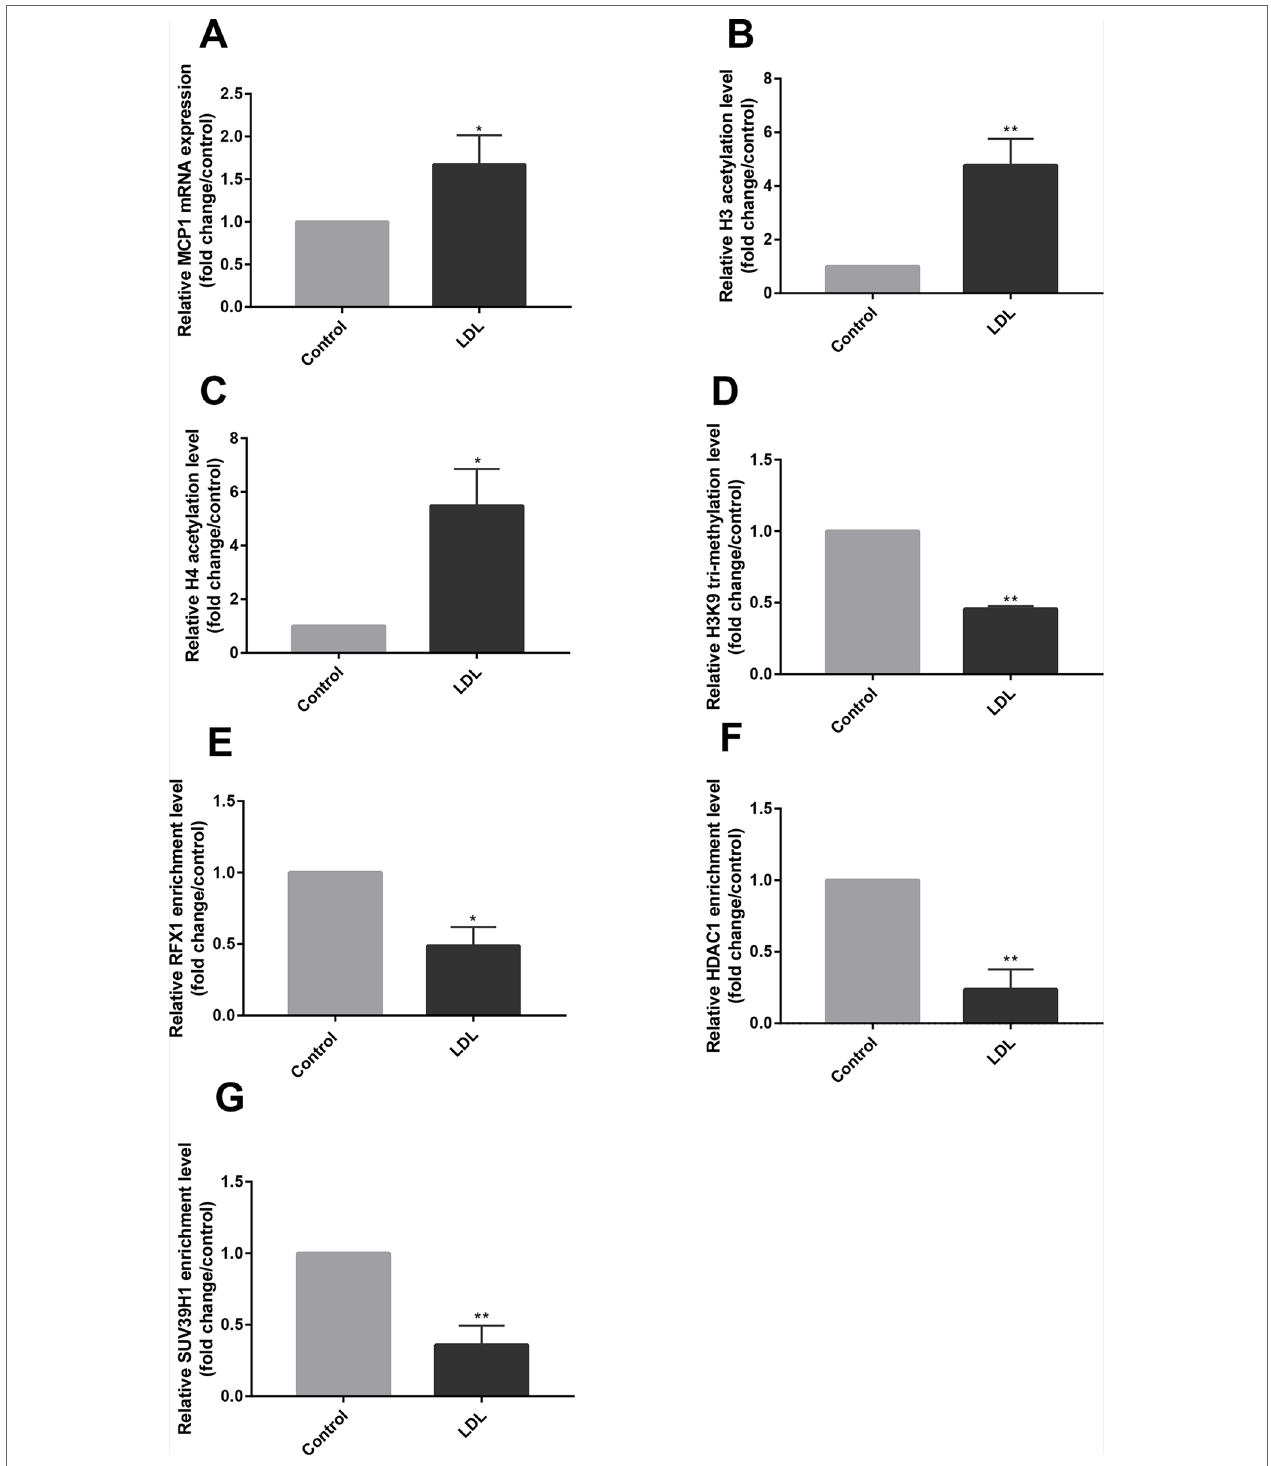
FigURE 3 | LDL altered histone modifications of the MCP1 promoter region in CD14+ monocytes. CD14+ monocytes were treated with LDL at 100 mg/L for 24 h. (a) The relative mRNA expression of MCP1 in CD14+ monocytes was detected by RT-qPCR. (B – D) ChIP-qPCR was used to measure the fold change of relative histone H3 (B) and H4 acetylation (C) and H3K9 tri-methylation (D) in the promoter region of the MCP1 gene in CD14+ monocytes treated with or without LDL. (E–g) The fold change of relative recruitments of RFX1 (E) , HDAC1 (F) and SUV39H1 (g) in the promoter region of the MCP1 gene in CD14+ monocytes were detected by ChIP-qPCR. All values are the average of at least three biological replicates, and the data shown are the mean ± SEM. * P 0.05 and ** P 0.01 compared with the control